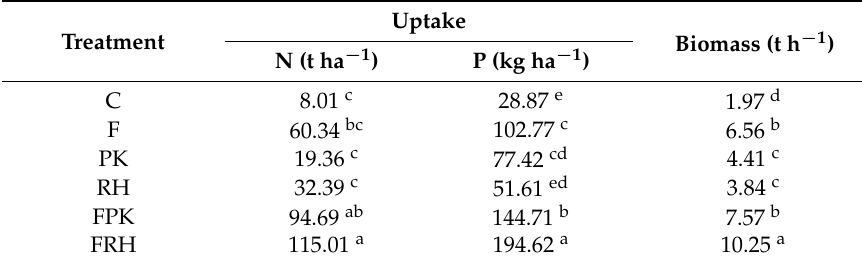
Table 5. Plant nutrient uptake and biomass after the 75 day of planting. Treatment